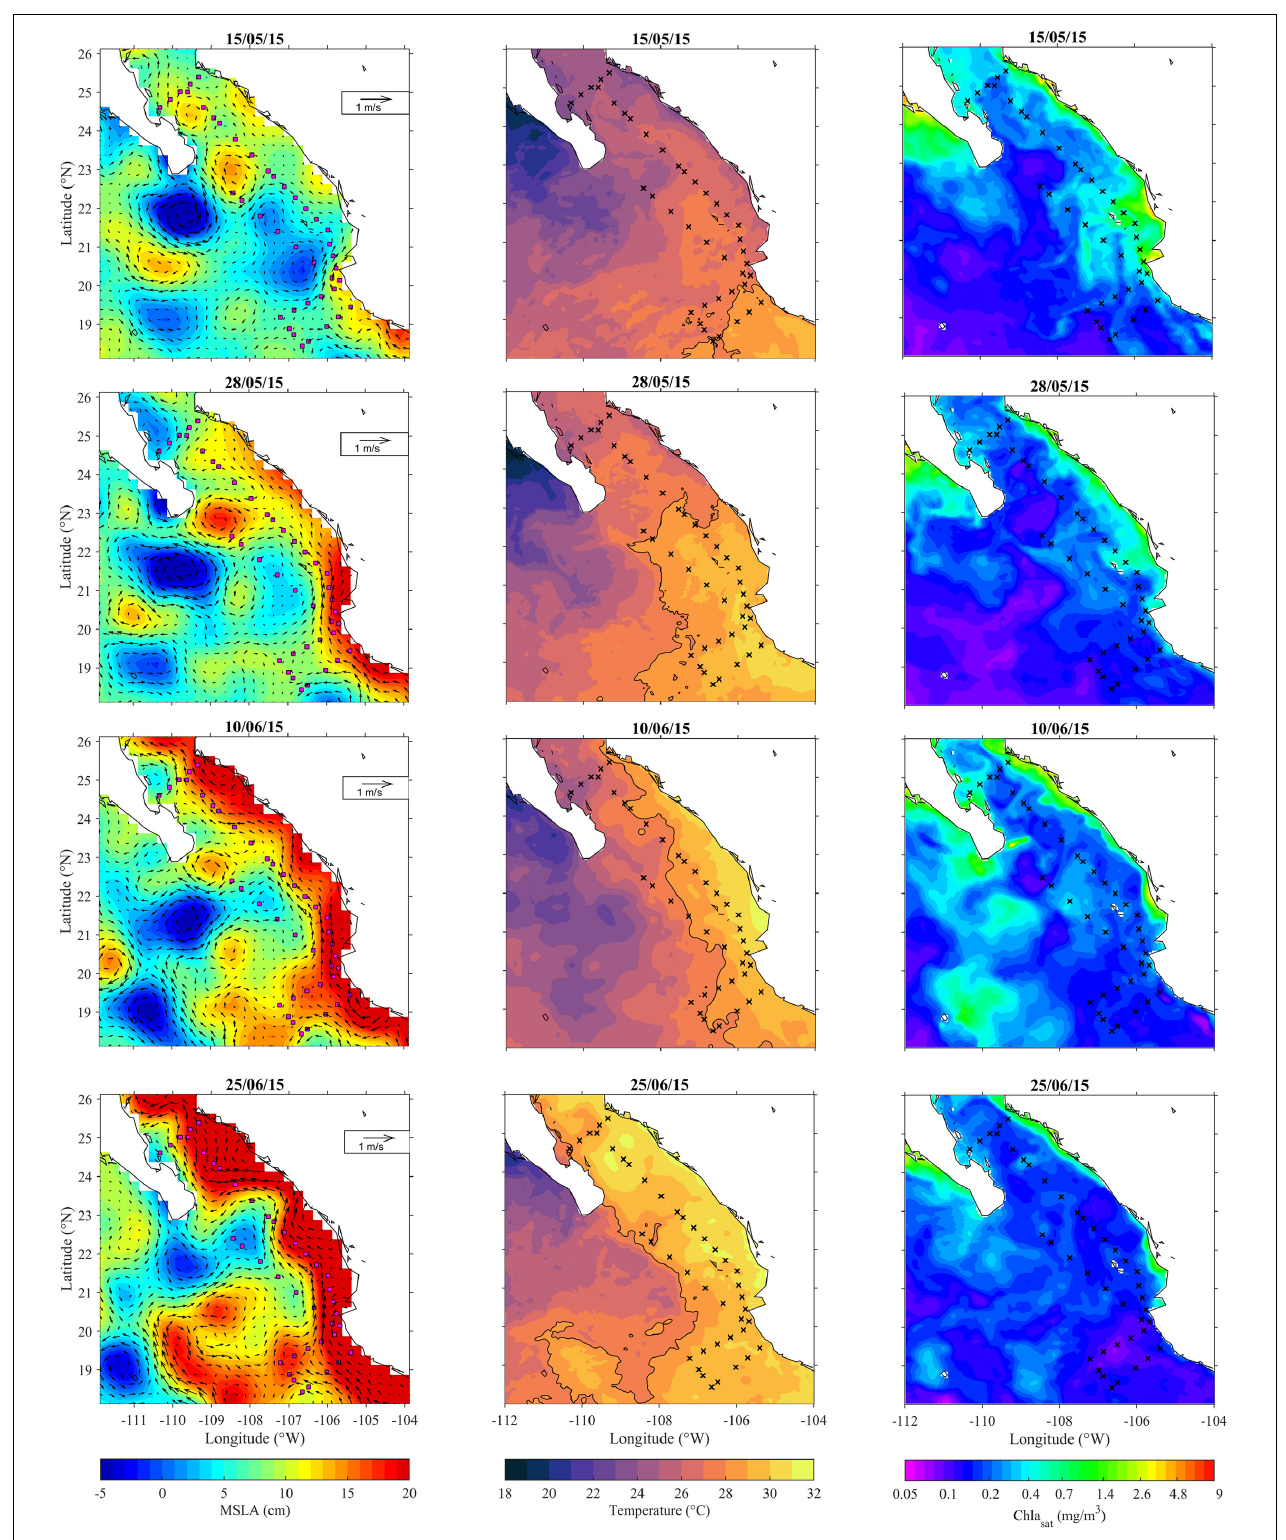
FIGURE 10 | Daily composition of mean sea level anomaly (MSLA, distributed by Aviso), sea surface temperature (GHRSST, the isotherm of 28 ◦ C in solid line), and satellite chlorophyll (Chla sat distributed by